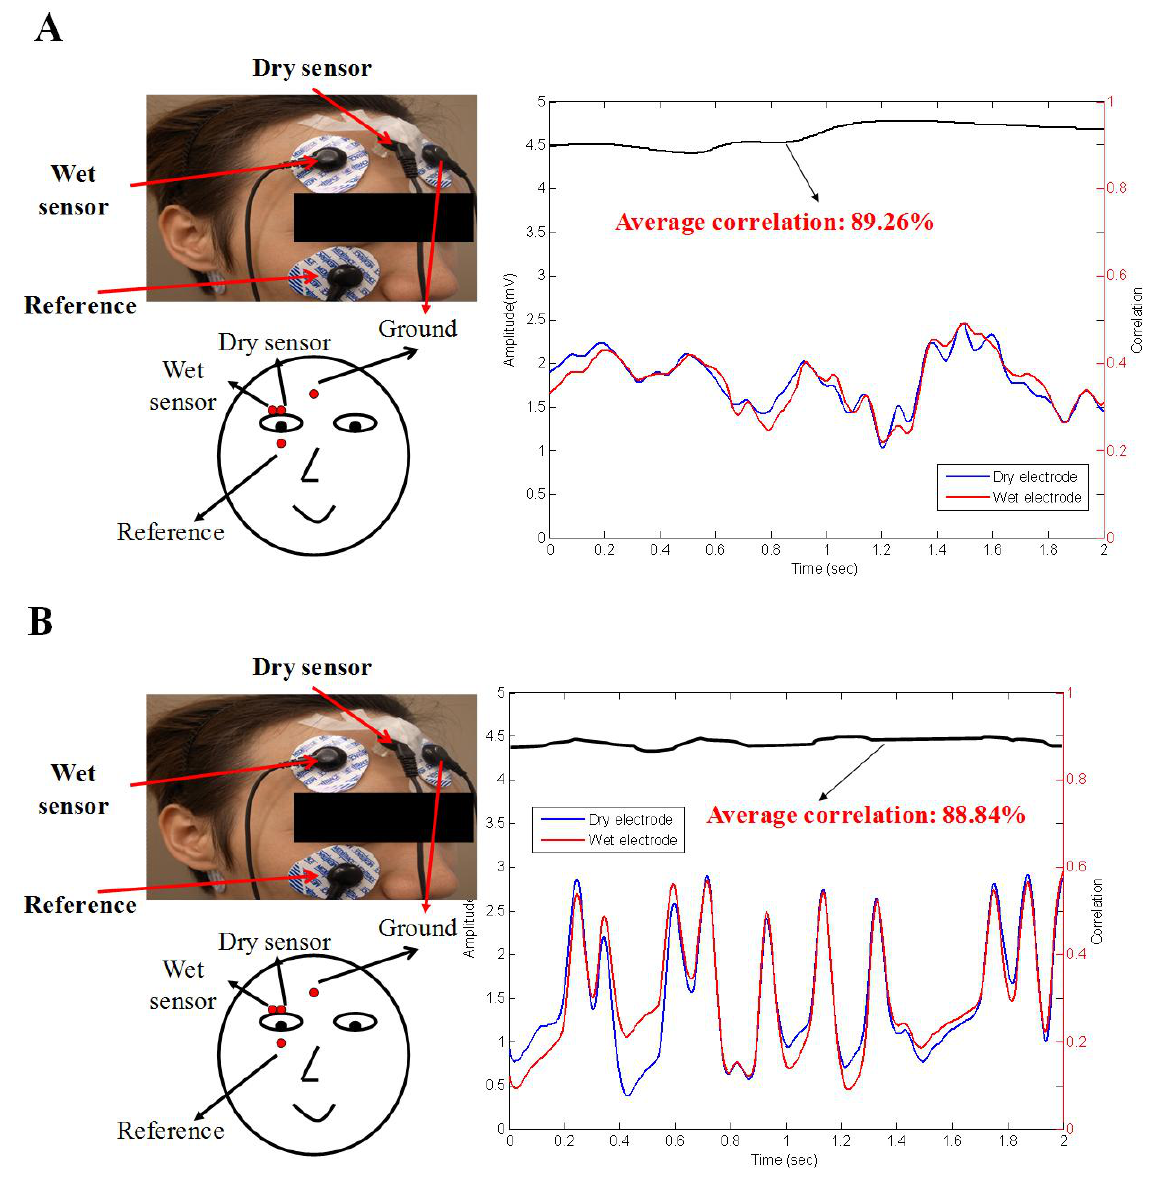
Figure 10. Signal comparison, as recorded by the wet electrodes and the proposed dry sensors. ( A ) The EOG measurements on a forehead site and ( B ) eye-blink signals on a forehead site are